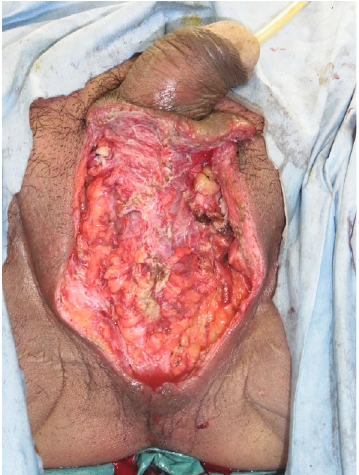
Figure 1: Case 1, primary surgery. Bilateral scrotum and testes were